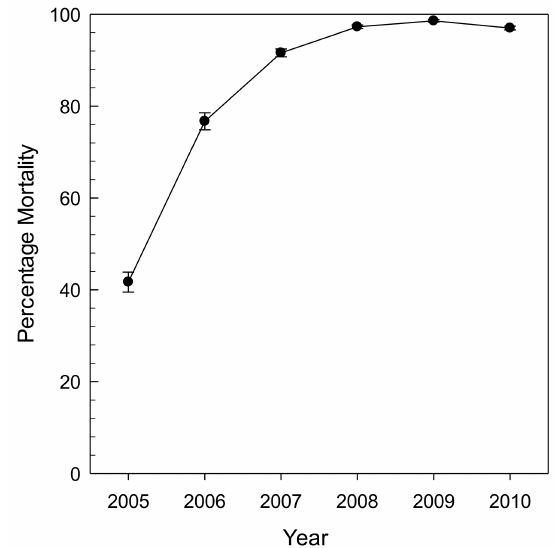
Figure 4. Percentage of ash mortality of trees >2.5 cm at 1.37 m height in subplots and >12.5 cm at 1.37 m height in main plots from 38 stands that included black, green, and white ash in the Huron River watershed in lower Michigan (reprinted with permission,